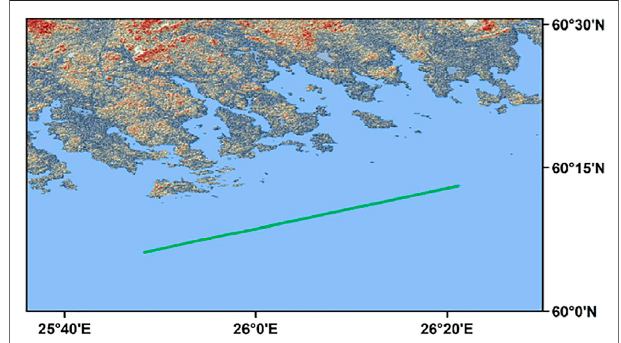
FIGURE 2 | Flight path of the experimental data over Baltic Sea used in this